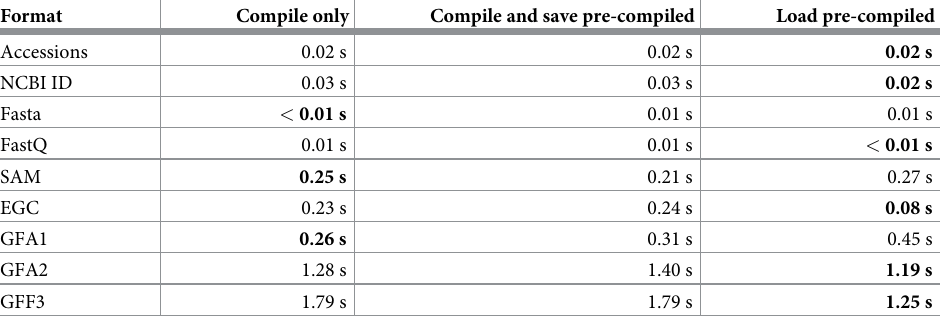
Table 2. Time for compilation of TFSL specifications from YAML files and loading of pre-compiled